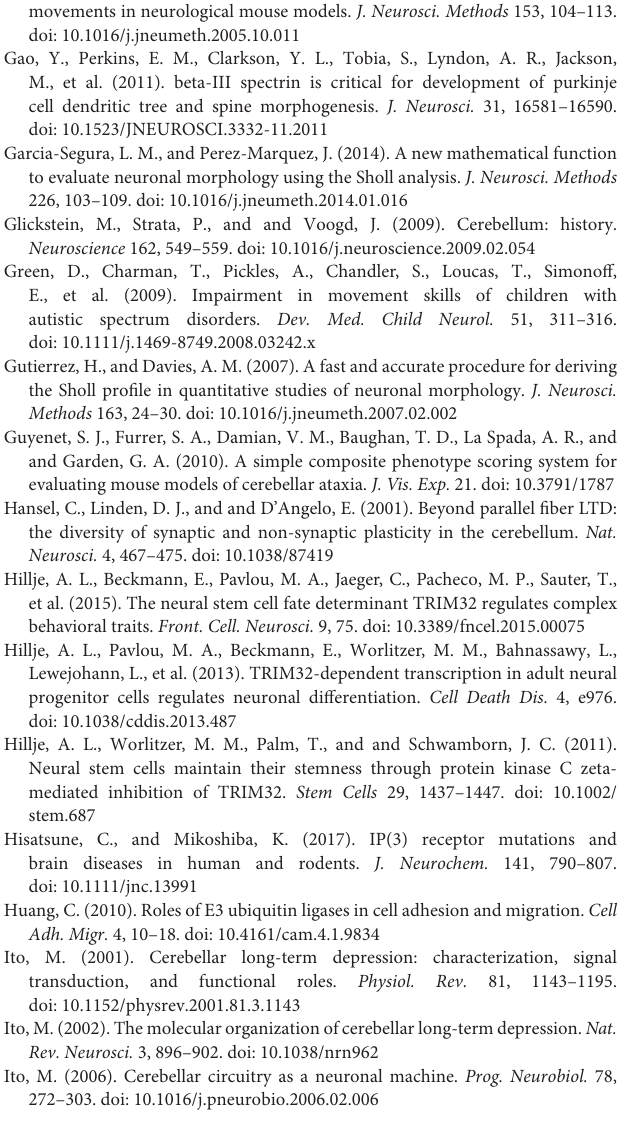
10-month-old mice. (C) Quantitative analysis of NeuN-expressing granule cells in GCL. Scale bar = 50 µ m. Data are presented as mean ± SEM. n = 5 mice/genotype. Supplementary Video 1 | Performance during the ladder rung task. TRIM32 − / – mice (right) walked slowly with frequent limb slips on the bars, as compared to WT mice (left), with both the regular rung pattern (upper) and the irregular rung pattern (lower). Supplementary Video 2 | Performance during the beam walk test. TRIM32 − / – mice (right) walked slowly with frequent limb slips on the beam as compared to WT mice (left). TRIM32 − / – mice had difficulty placing their limbs and clasping the beam when walking forward. Supplementary Video 3 | Performance during the ledge test. TRIM32 − / – mice (right) placed their limbs close to the side walls of the ledge instead of on the ledge surface like WT mice (left) while walking along the ledge. TRIM32 − / – mice exhibited a slower walking pace and a greater number of limb slips than WT